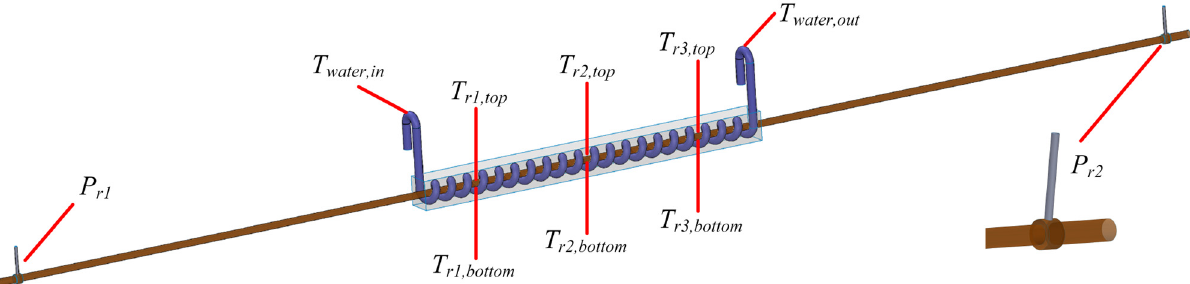
Figure 2. Schematic of the test section.